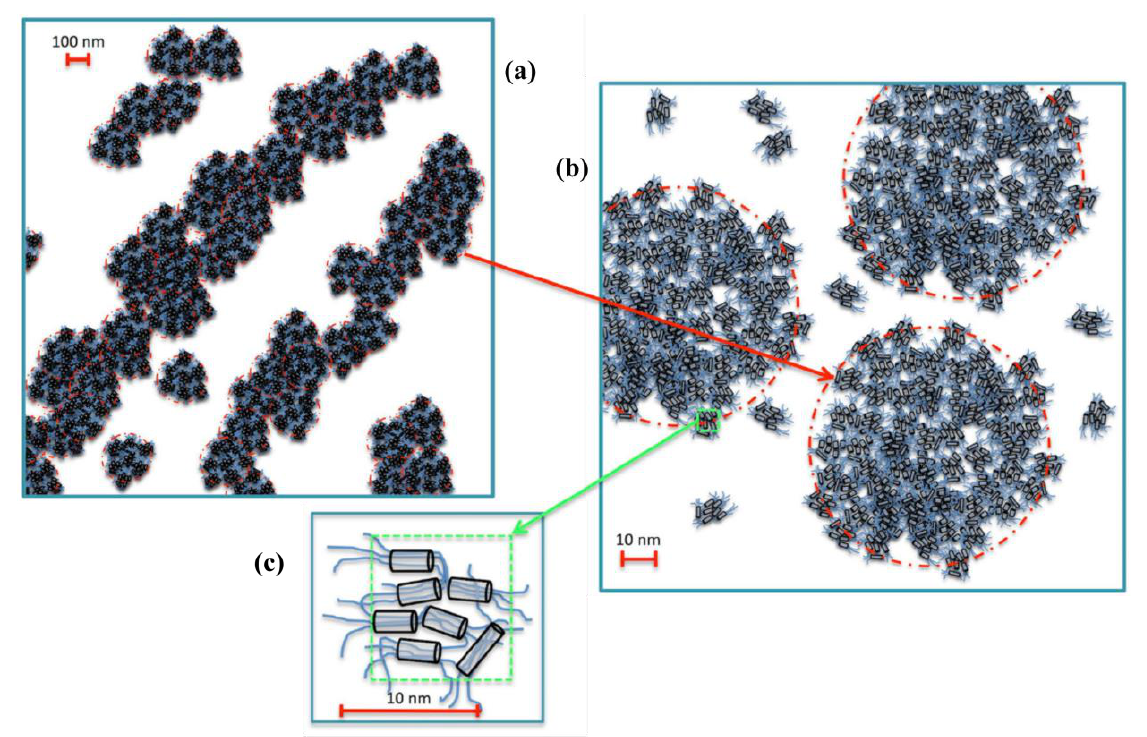
Figure 3. Scheme of the hierarchically organized self-assembly of XG in water, as deduced from SALS, LALS and SAXS determinations of 3 and 4 wt% XG dispersions at 25 °C. Large fiber-like aggregates ( a ) consist of small-scale aggregates ( b ) that are formed by the self-assembly of polymer chains ( c ). (Reproduced from [33] with permission from Springer Nature B.V.)